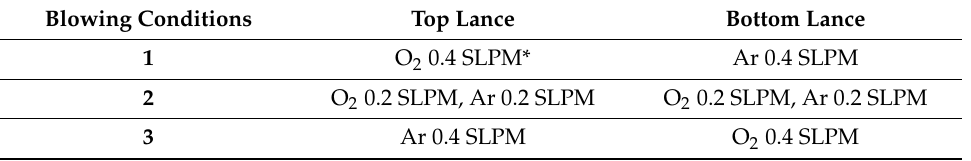
Table 2. Gas blowing conditions for hot metal desiliconisation and dephosphorisation. Blowing